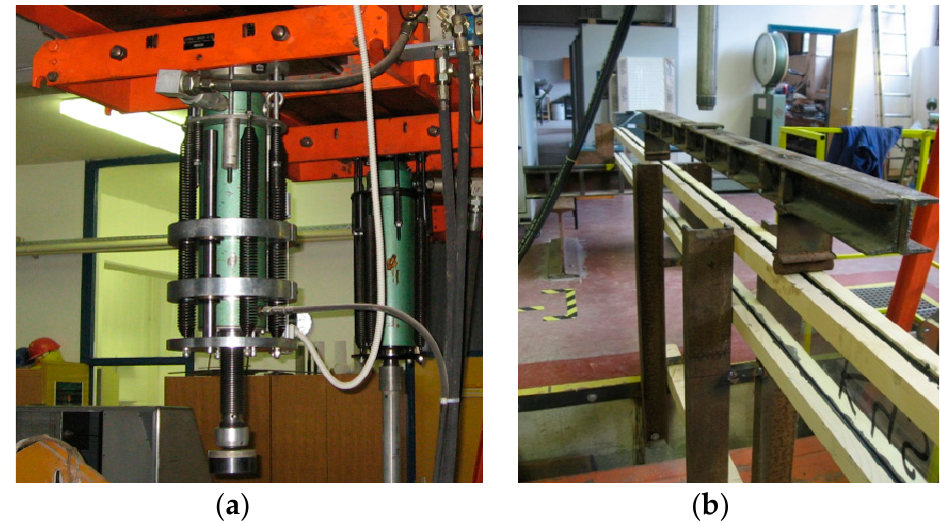
Figure 15. ( a ) hydraulic piston; ( b ) weight yoke through which the force of the piston was transmitted to the specimen. into the timber during the test.